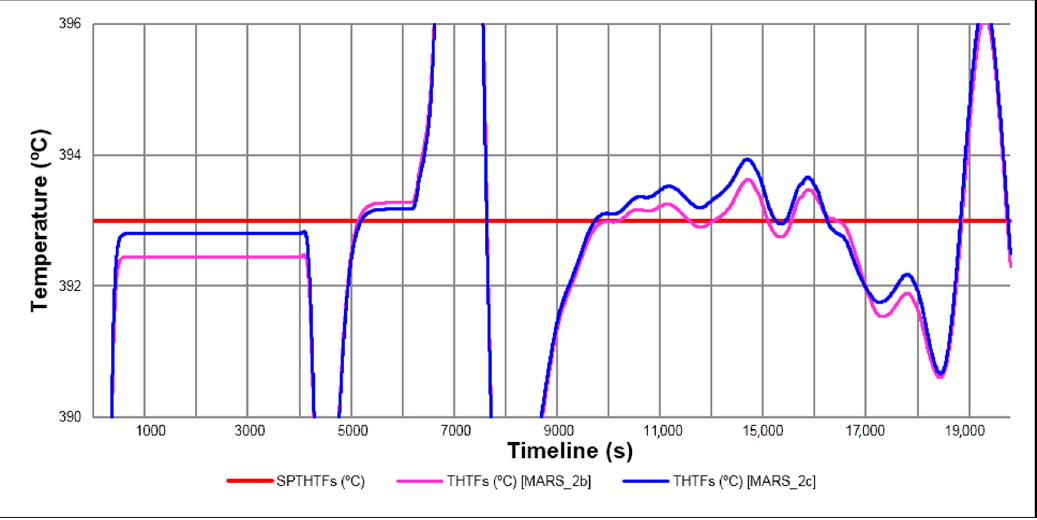
Figure 6. Comparison between the MARS model and real input data—September 2010.